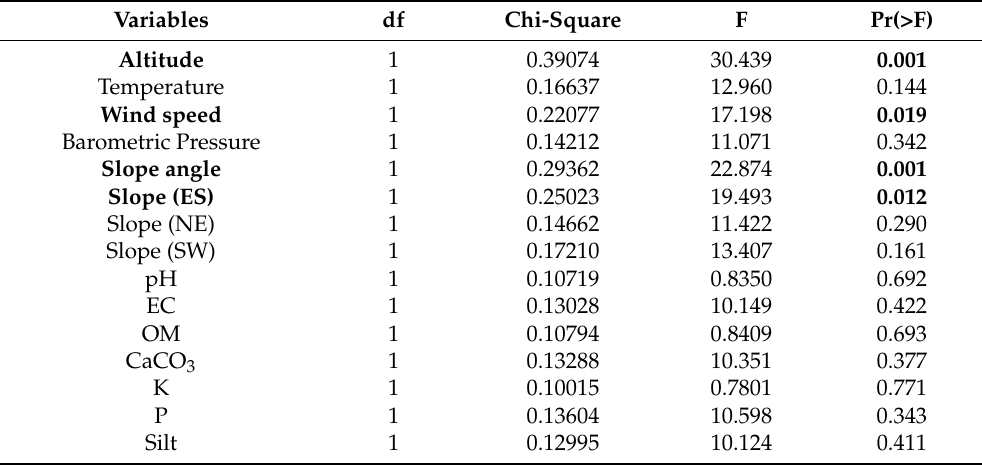
Figure 8. Variation of diversity indexes among the three plant communities recognized in pure Deodar forest (GLM results and associated p -values are displayed at each plot). ( a – d ) Species richness ( a ), Shannon diversity ( b ), Simpson diversity ( c ), and Pielou’s evenness ( d ). (For the complete names of plant communities, see Figure 2). Table 3. Contribution and ranking of the variables fit in our final model. Significant p -values are displayed in